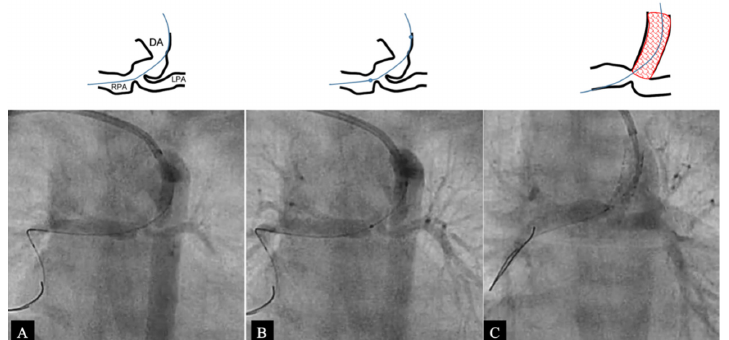
Figure 6. Stenting of vertical ductus arteriosus (DA) associated with bilateral proximal pulmonary artery branch stenosis and hypoplastic left PA. ( A ) Selective hand injection of the ductus in cranial projection after the guidewire placed at the right lower PA. ( B ) Length interrogation was performed with coronary balloon catheter, 2.5 × 15 mm. ( C ) Stent was placed just proximal to the PA bifurcation. The underfilled left PA immediately increased in size after stenting. RPA: Right pulmonary artery, LPA: Left pulmonary artery. the subclavian artery to an ipsilateral pulmonary artery. Stenting of the DA can be achieved with the same principles and methods, as mentioned earlier. (Figure 7) How- ever, due to single lung supply, the stent diameter should be 0.5–1 mm smaller than the recommended size [11].